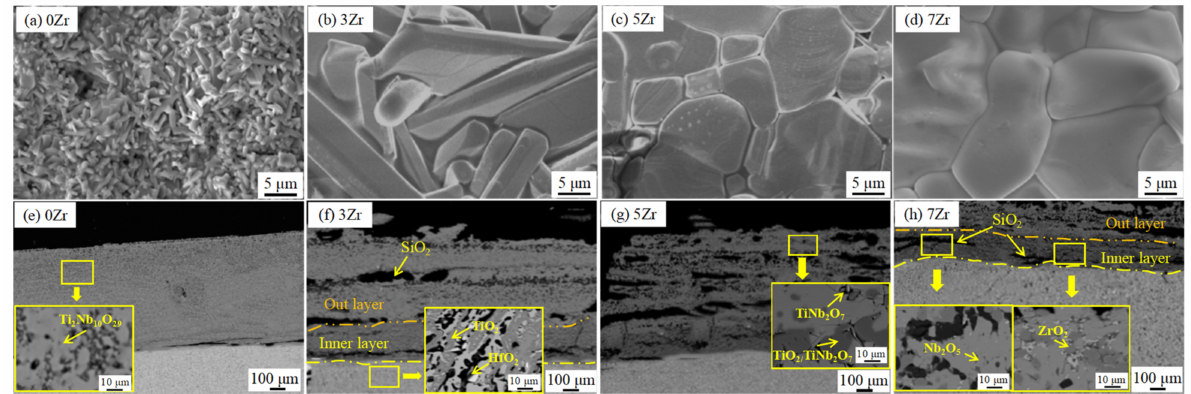
Figure 8. Surface morphologies and cross-sectional microstructures of Nb-15Si-24Ti-4Cr-2Al-2Hf-xZr (x = 0 at.%, 3 at.%, 5 at.%, 7 at.%) alloys after oxidation at 1300 ◦ C for 100 h. ( a , e ) 0Zr; ( b , f ) 3Zr; ( c , g ) 5Zr; ( d , h ) 7Zr. Copyright 2019